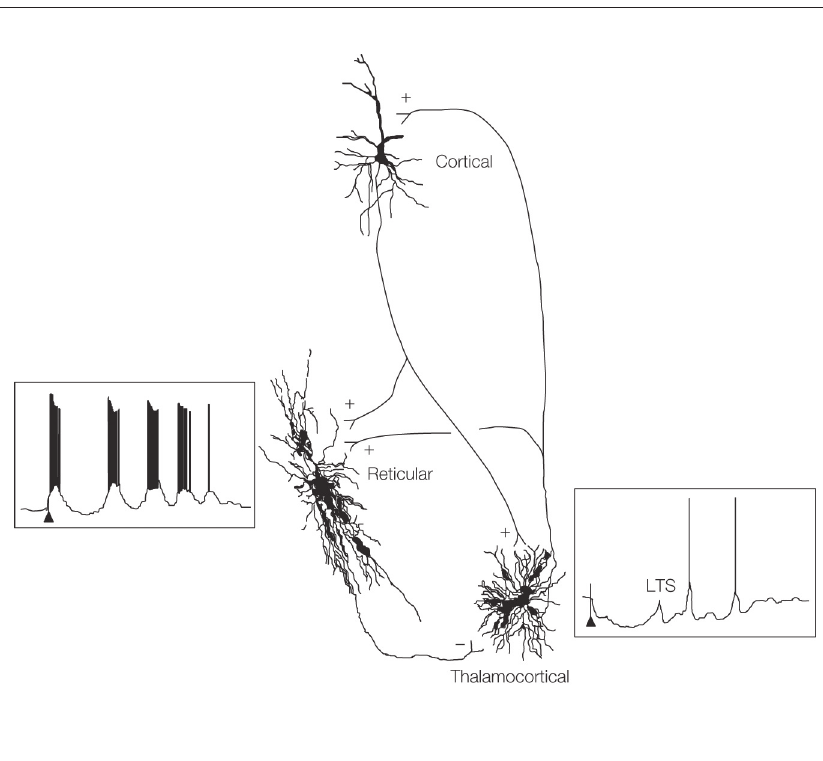
FIGURE 1 | Sleep, epilepsy and thalamic reticular inhibitory neurons. Steriade M. Cortical, reticular and thalamocortical neurons showing connectivity (+ excitation, - inhibition), intracellular recordings and anatomical reconstructions from cats. Cortical stimulation (arrows) leads to a sequence of spindle waves in the reticular cell and to a series of low-threshold spikes (LTS) in the thalamocortical cell. From Steriade